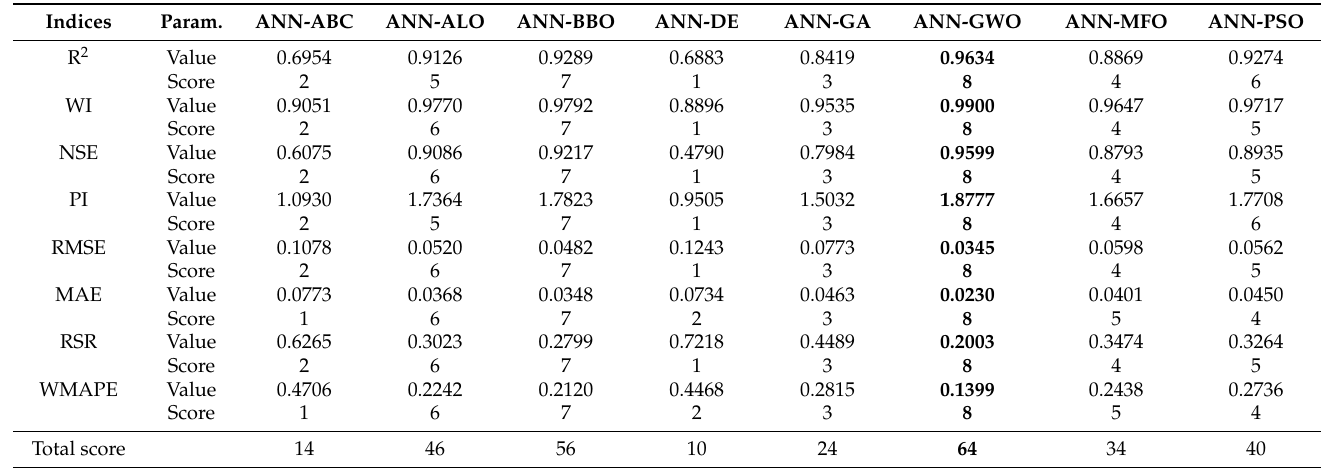
Table 7. Model performance in the testing phase.